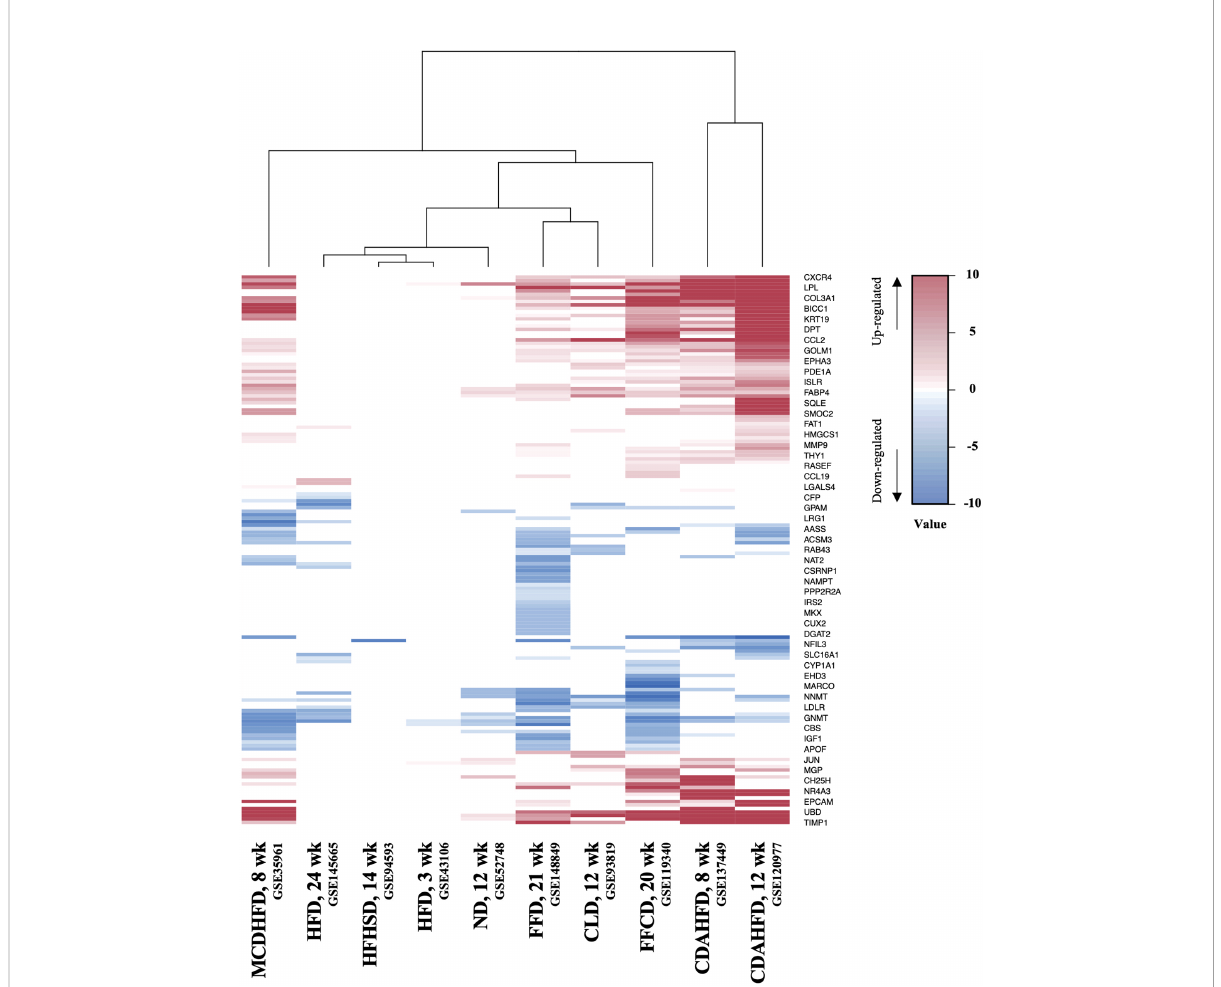
FIGURE 3 Heatmap of gene expression pro fi les of different NASH mouse models. DEGs from 10 mouse NASH datasets were merged based on the gene symbols, and the fold change values of dysregulated genes were normalized. Gradient of red color represents high expression of genes, whereas gradient of blue color represents low expression of genes in mouse NASH group. MCDHFD, methionine- and choline-de fi cient diet with high-fat diet; HFD, high-fat diet; HFHSD, high-fat high-sugar diet; ND, NASH-inducing diet; FFD, fast food diet; CLD, high-cholesterol high-cholate high-fat diet; FFCD, fat fructose cholesterol diet; CDAHFD, choline-de fi cient L-amino acid de fi ned high fat